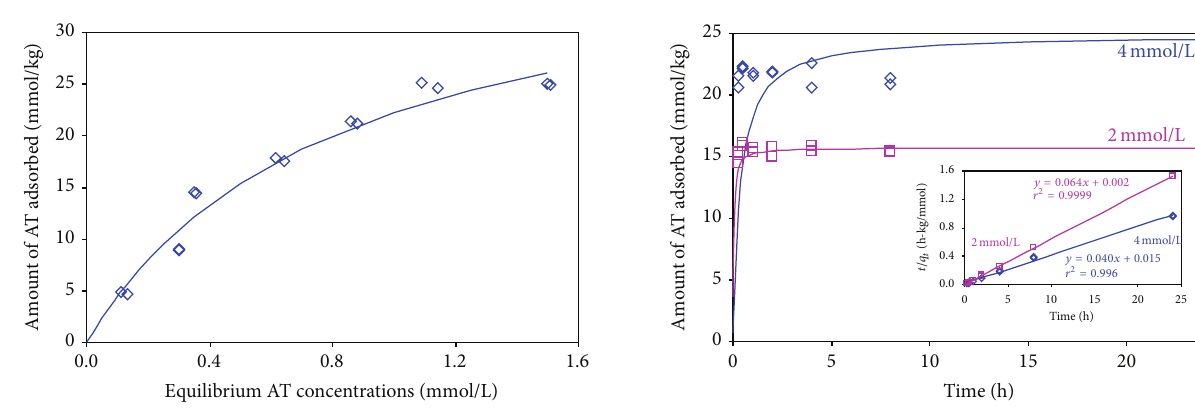
Figure 2: Adsorption of atenolol on kaolinite. The line is the Langmuir fit to the observed data.